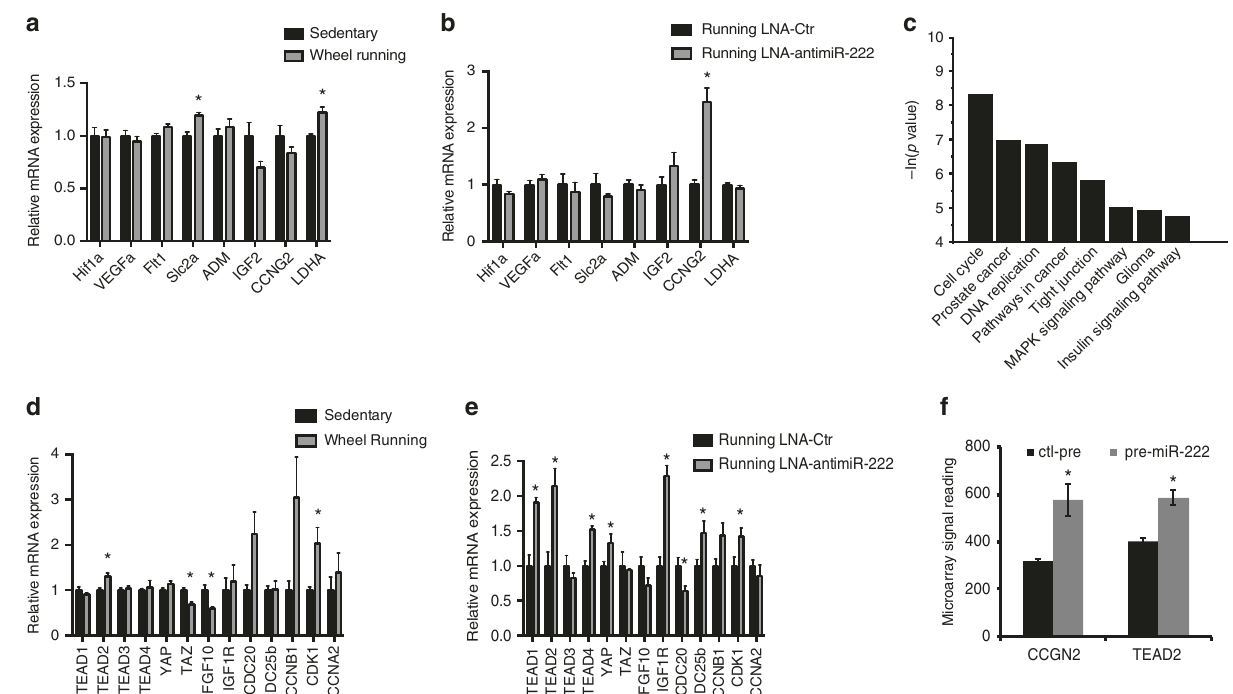
Fig. 5 Hypoxia and hippo pathways are not directly targeted by miR-222. a , b qPCR was used to analyze mRNA levels of genes relevant for hypoxia-induced effects in exercised vs. sedentary hearts ( a ) and hearts from mice treated with LNA-anti-miR222 or LNA-scr-miR undergoing voluntary wheel running ( b ) ( n = 3 – 5 mice per group, * p < 0.05, Student ’ s t test). c p value from signi fi cantly differential pathways analyzed by ingenuity pathway analysis (IPA, Qiagen) of a microarray conducted from neonatal rat ventricular myocytes (NRVM) treated with control precursor (ctl-pre) and miR-222 precursor (pre- miR-222), respectively ( n = 4 individual samples per group). d , e qPCR was used to analyze mRNA levels of genes relevant for hippo pathway-induced effects in exercised vs. sedentary hearts ( d ) and hearts from mice treated with LNA-anti-miR222 or LNA-scr-miR undergoing voluntary wheel running ( e ) ( n = 3 – 5 mice per group, * p < 0.05, Student ’ s t test). f Gene expression signal speci fi cally for CCGN2 and TEAD2 detected in a microarray conducted from neonatal rat ventricular myocytes (NRVM) treated with control precursor (ctl-pre) and miR-222 precursor (pre-miR-222), respectively ( n = 4 individual samples per group, * p < 0.05, Student ’ s t test). Error bars represent ±